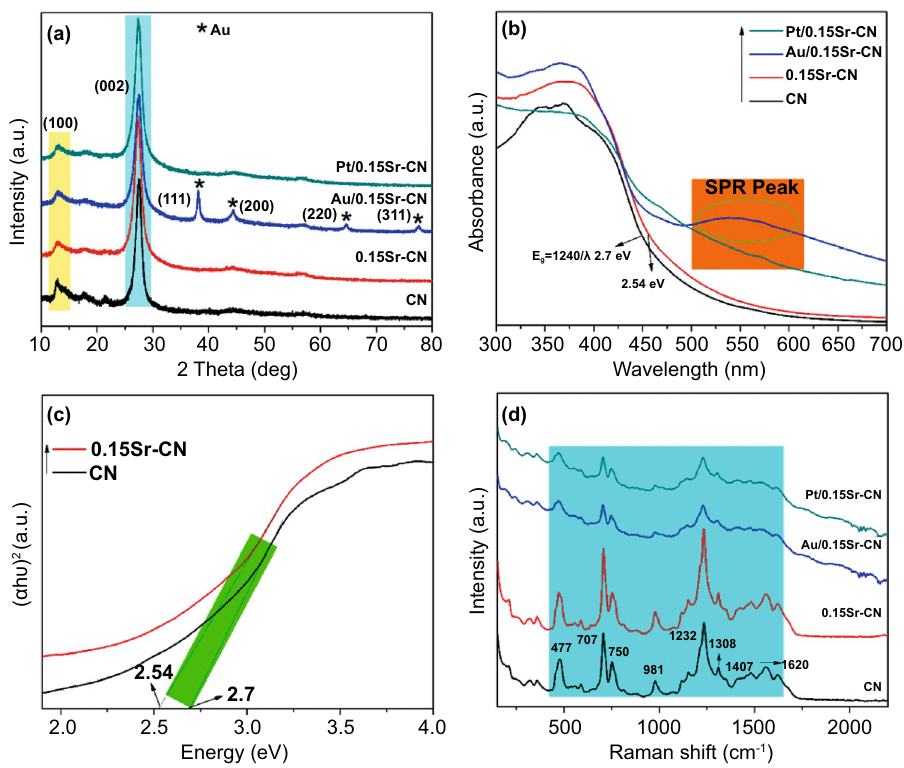
Fig. 1 a XRD patterns and b UV–visible absorption spectra of CN, 0.15Sr-CN, Au/0.15Sr-CN, and Pt/0.15Sr-CN. c Estimated band gaps of CN and 0.15Sr-CN and d Raman spectra of CN, 0.15Sr-CN, Au/0.15Sr-CN, and